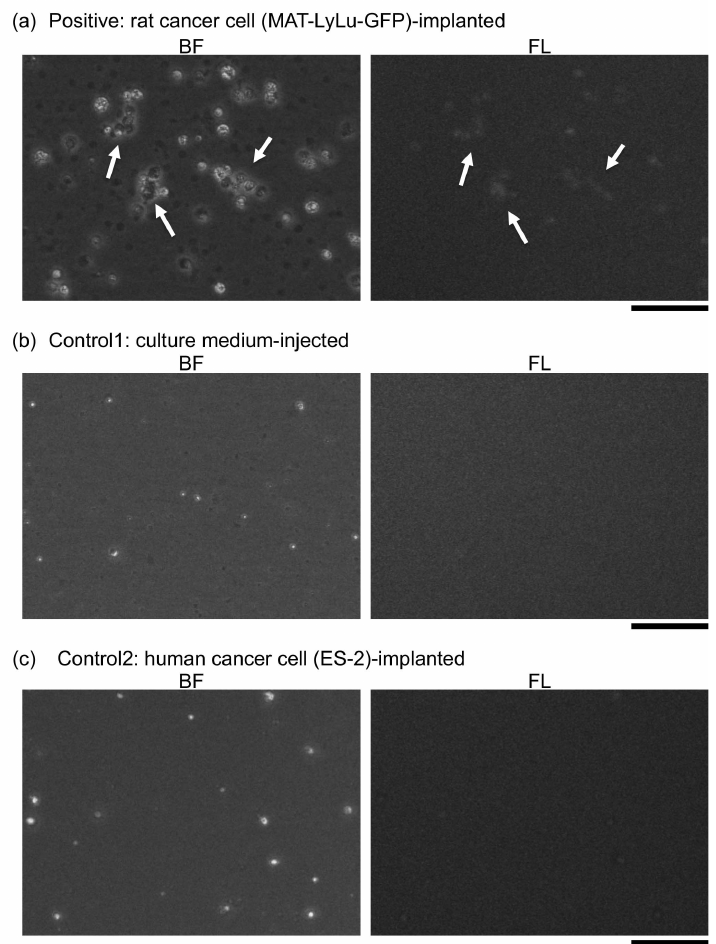
Figure 15. Photographs of cells for positive ( a ), control 1 ( b ), and control 2 blood ( c ) in wide areas. On the left are optical (BF) images of cells, while on the right are fluorescent (FL) images of corresponding positions. Arrowheads in ( a ) indicate cell clusters. Bars, 50 µ